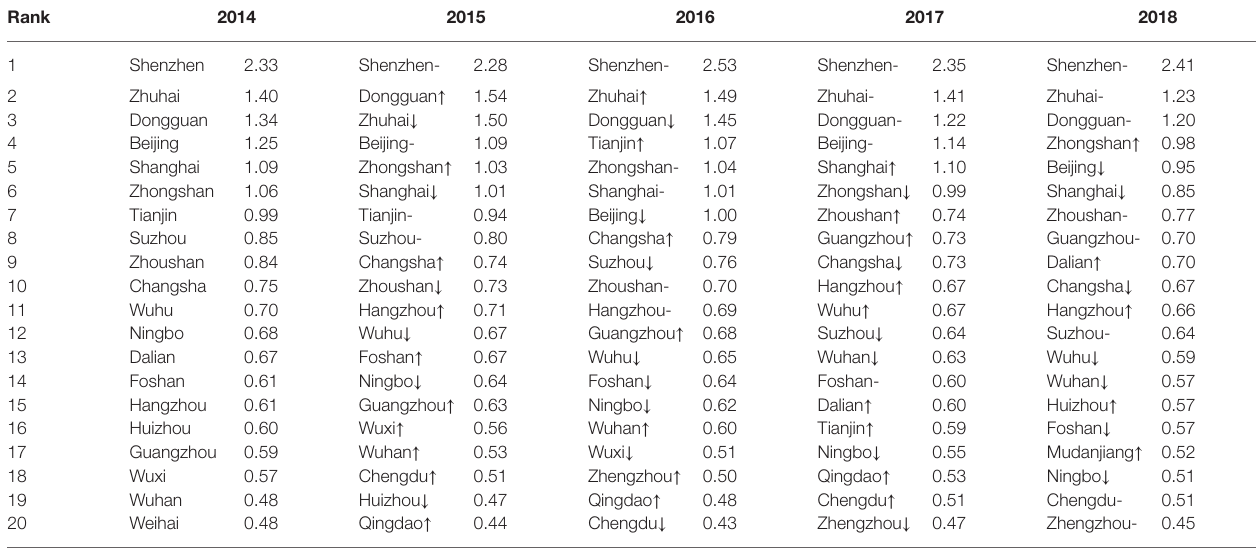
TABLE 3 | Results of the evaluation of high-quality economic development of cities.